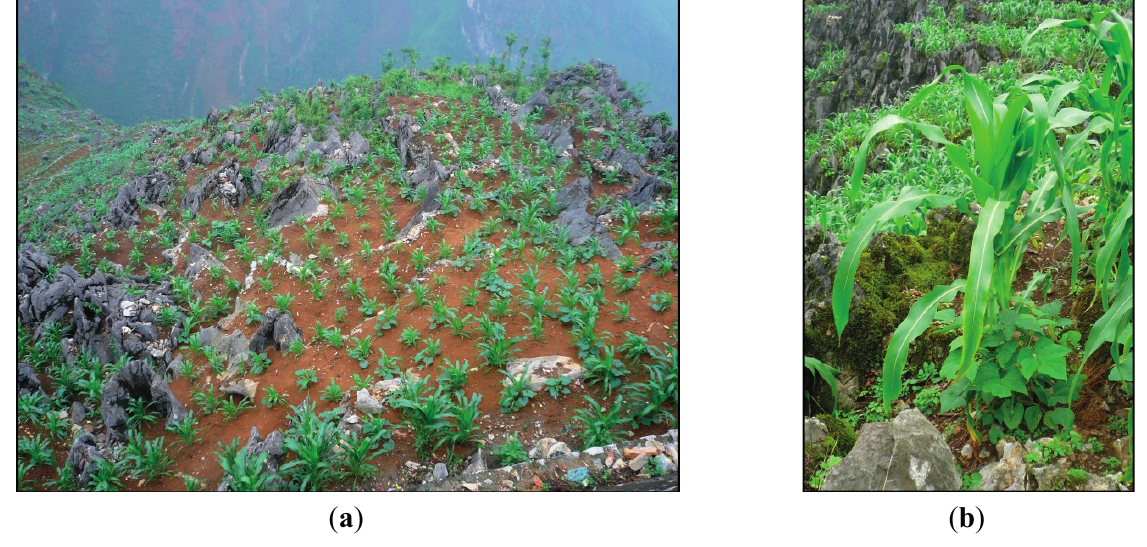
Figure 8. ( a ) Typical small fields with numerous karst outcrops, and ( b ) local maize with runner beans, Đồ ng V ă n District, Hà Giang Province. (Photo credit: Sarah